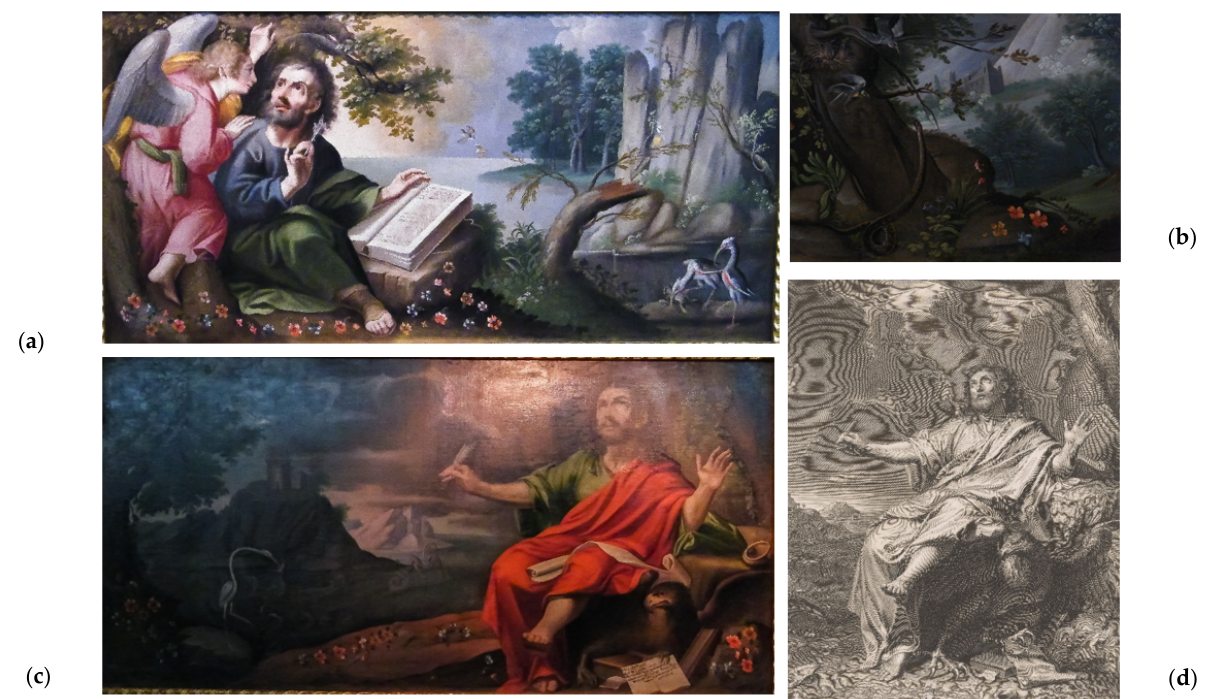
Figure 6. ( a ) Melchor Pérez de Holguín (ca. 1665–ca. 1730). Saint Mark the Evangelist , 1714, oil on canvas, Museo Nacional de Arte, La Paz, Bolivia. Credit line: Sebastian Ferrero. ( b ) Melchor Pérez de Holguín (ca. 1665–ca. 1730). Saint Luke the Evangelist , detail, 1714, oil on canvas, Museo Nacional de Arte, La Paz, Bolivia. Credit line: Sebastian Ferrero. ( c ) Melchor Pérez de Holguín (ca. 1665–ca. 1730). Saint John the Evangelist , 1714, oil on canvas, Museo Nacional de Arte, La Paz, Bolivia Credit line: Sebastian Ferrero. ( d ) François de Poilly after Charles Le Brun, Saint John the Evangelist at Patmos, 1657–1681, engraving, 442 mm × width 327 mm, credit line: Rijksmuseum, public domain.